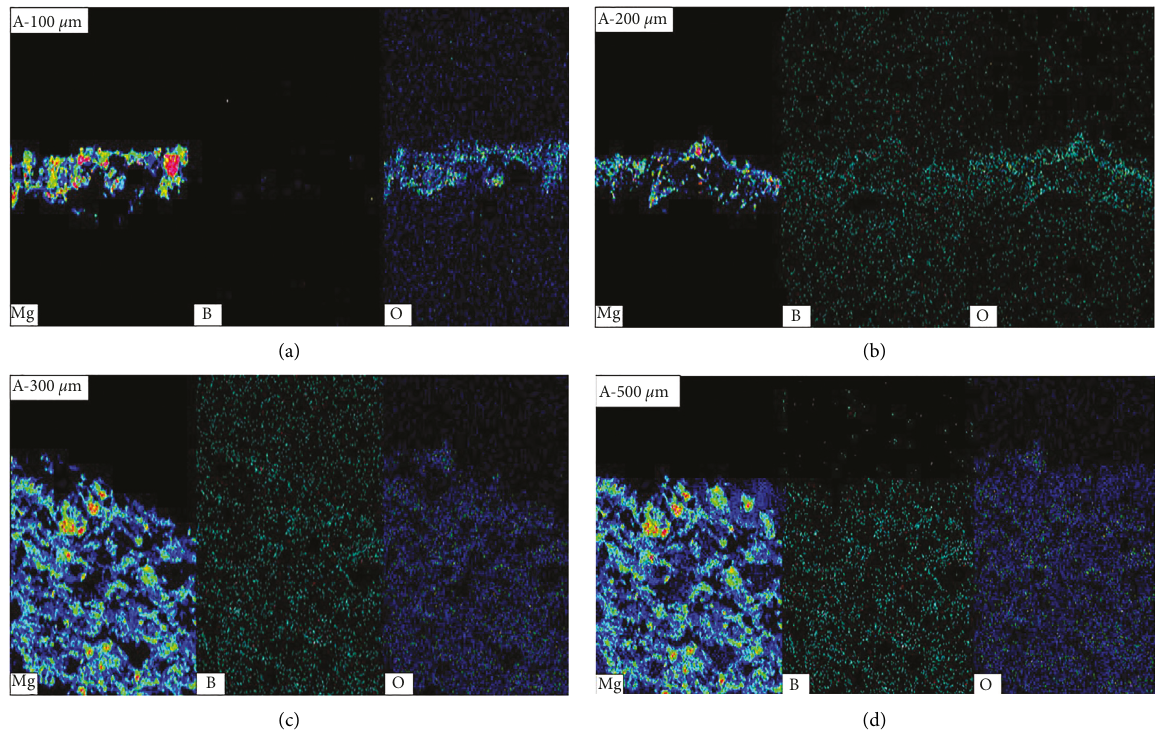
Figure 14: Microstructure of coating A by EPMA at different thicknesses. (a) 100 μ m. (b) 200 μ m. (c) 300 μ m. (d) 500 μ